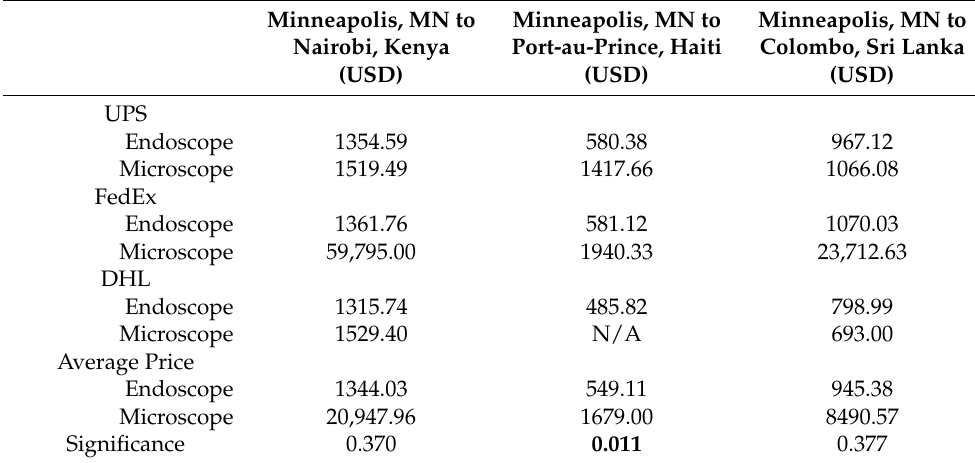
Table 1. International Shipping Fees: All fees are from packages dropped off in Minneapolis and directly delivered to international hospitals without accounting for insurance or customs fees. All microscope shipping fees are for air freight shipping.